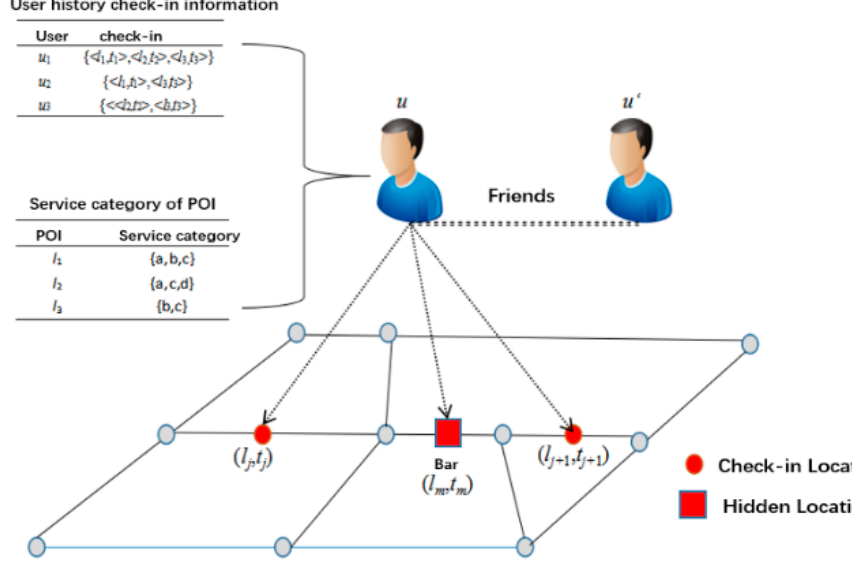
Figure 1. Illustration for hidden location attacks.